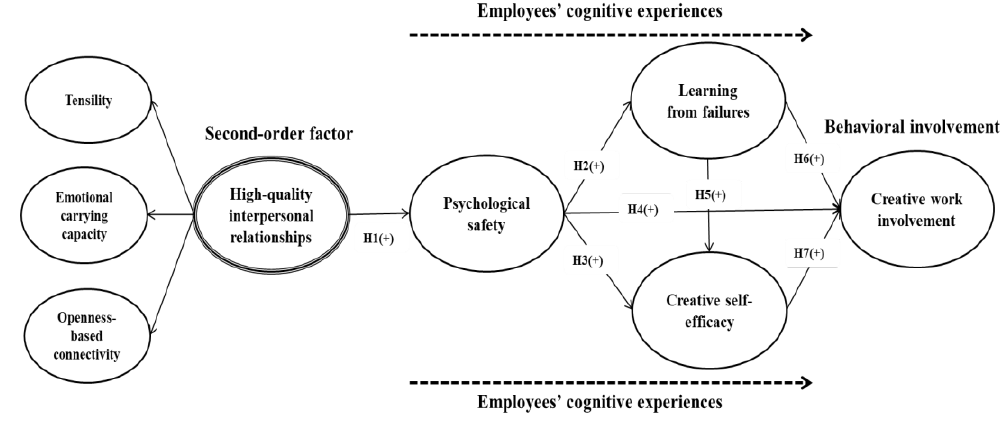
Figure 1. Proposed Study Model.